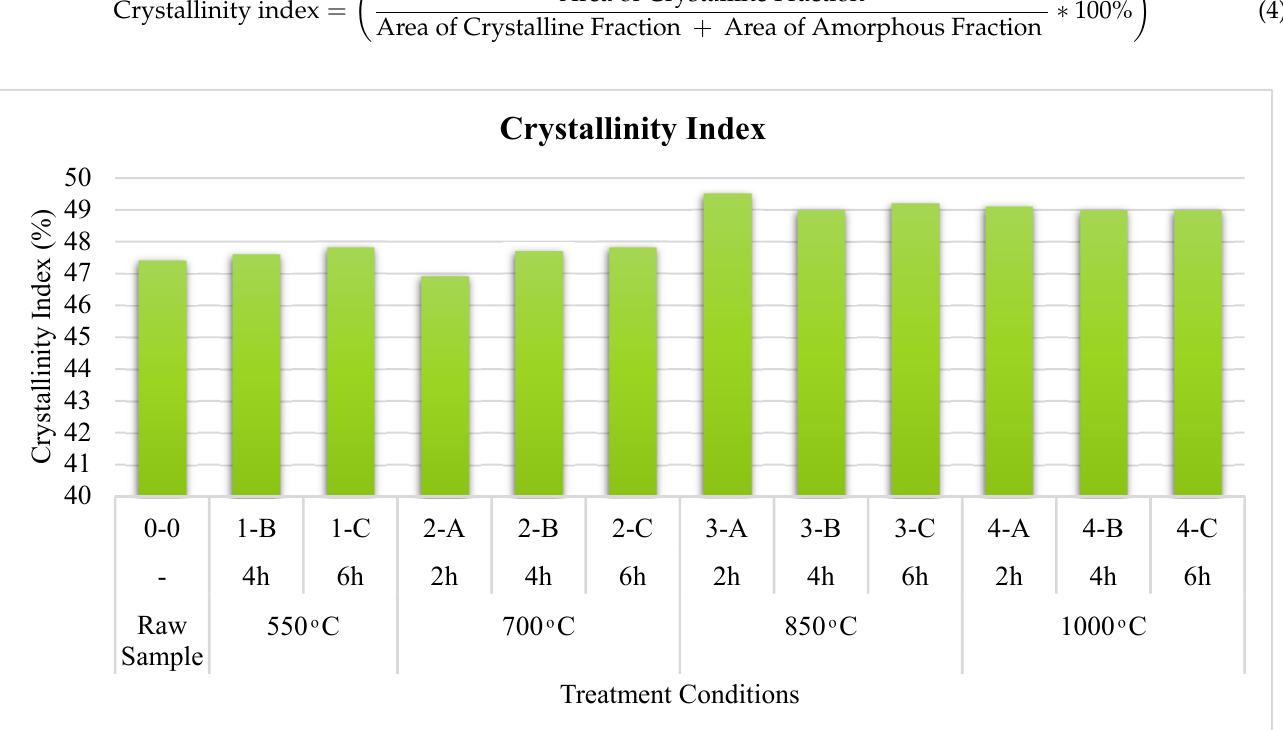
Figure 6. Relation between crystallinity index and treatment conditions for FOSA samples. The results indicated a minor change in the crystallinity indexes at low temperatures.